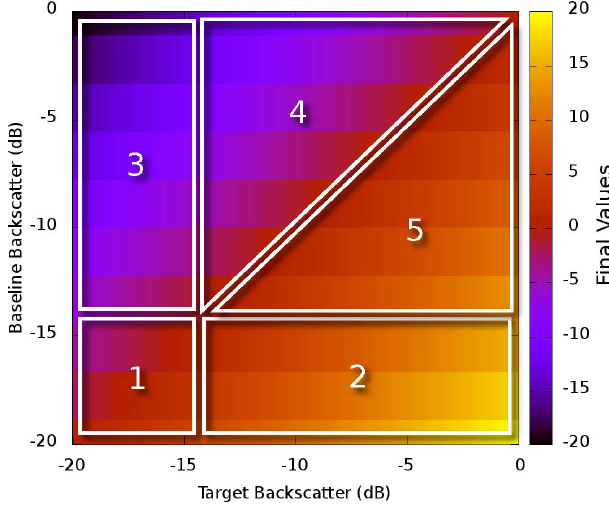
Fig. 3. Key map to describe range of 1σ 0 values derived from image differencing